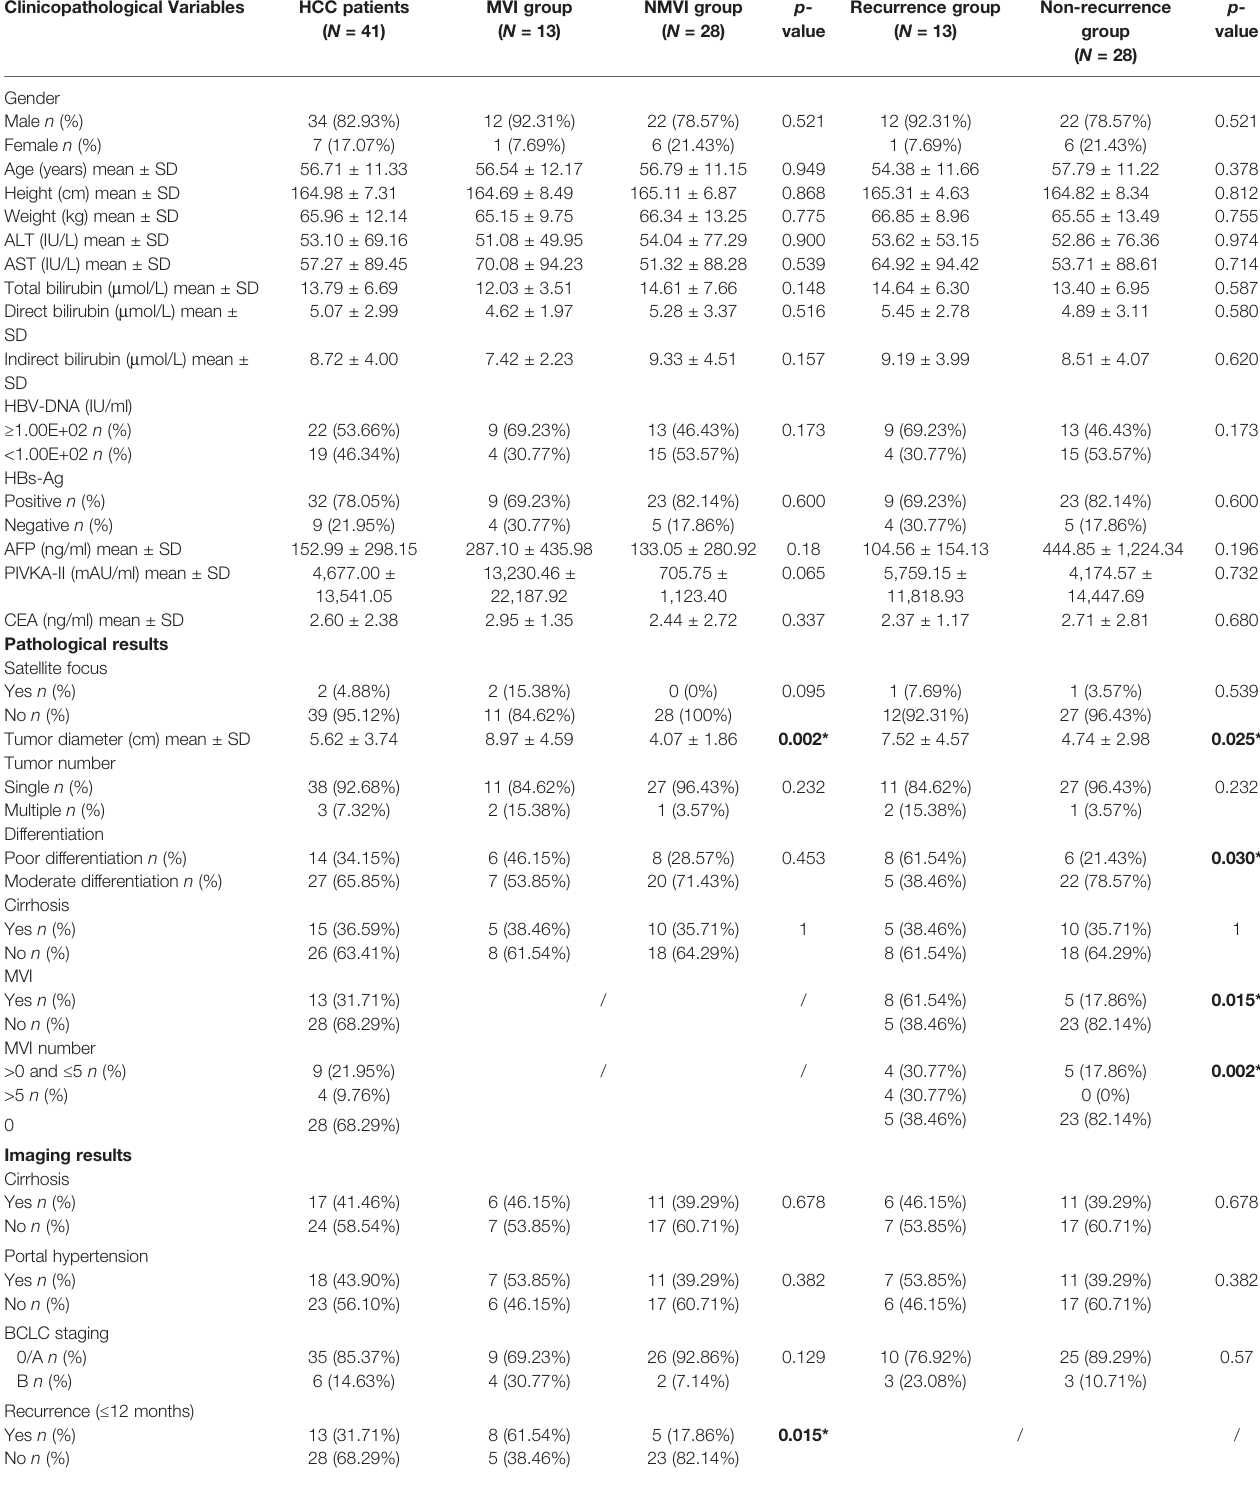
TABLE 1 | Clinicopathological characteristics of the HCC